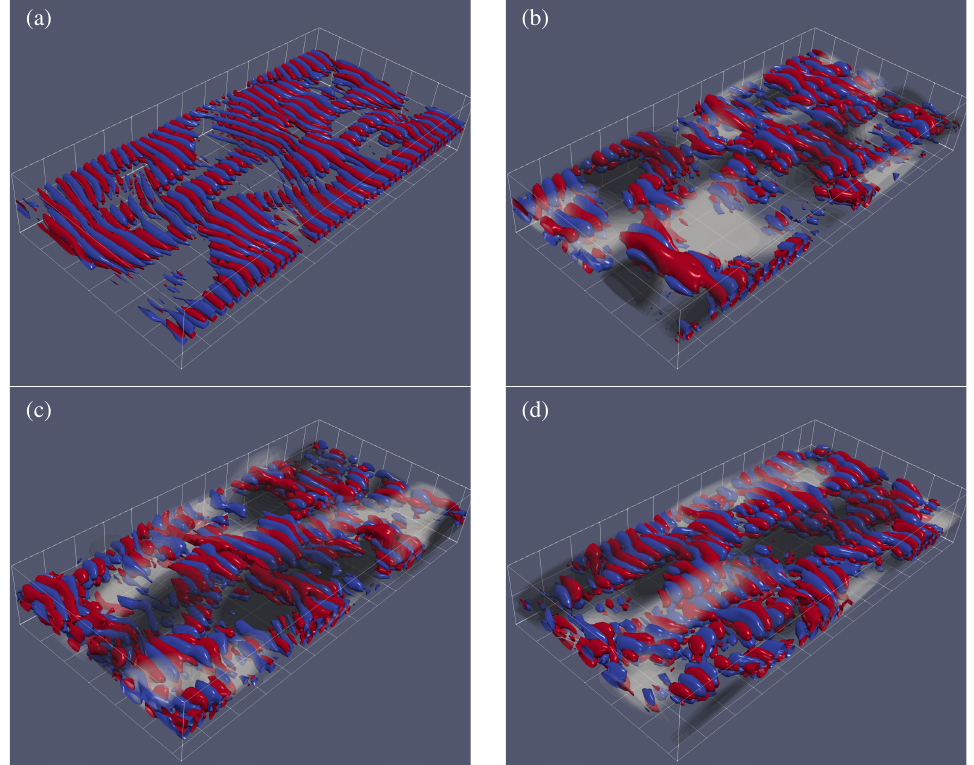
Figure 12. Spanwise-oriented structures and large-scale flows are the same as in Figure 11, but for Re = 100 at ( a ) Wi = 20, ( b ) Wi = 100, ( c ) Wi = 500, and ( d ) Wi =